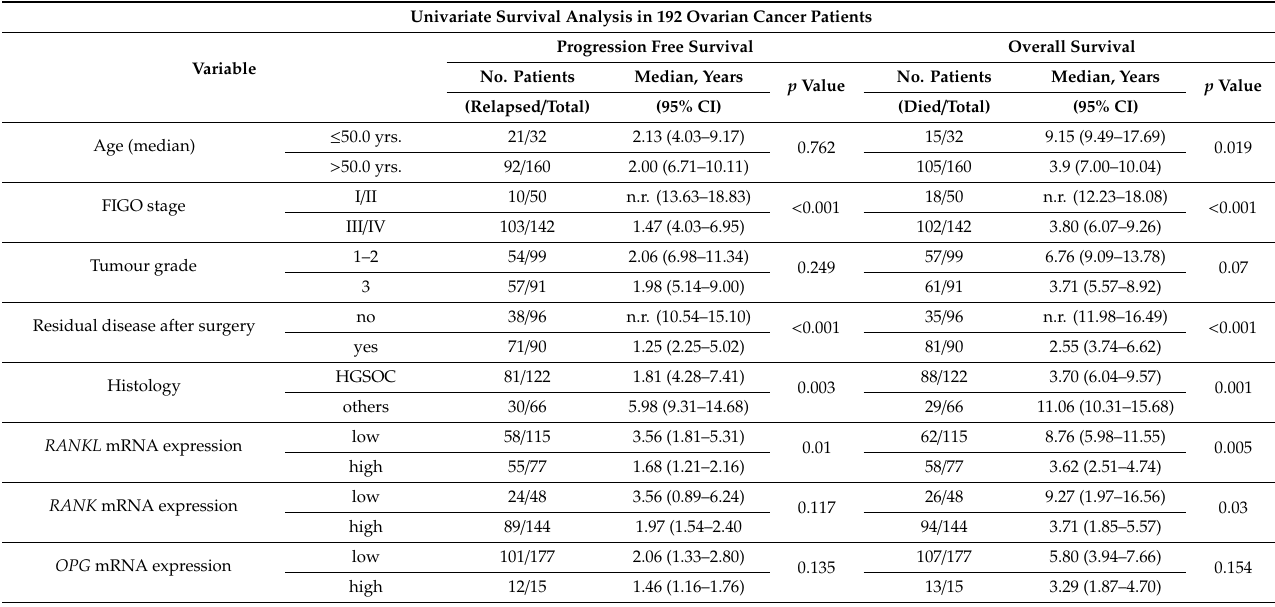
Table 1. Univariate and multivariate survival analysis in 192 ovarian cancer patients. RANK / RANKL / OPG cut-o ff was determined by the Youden